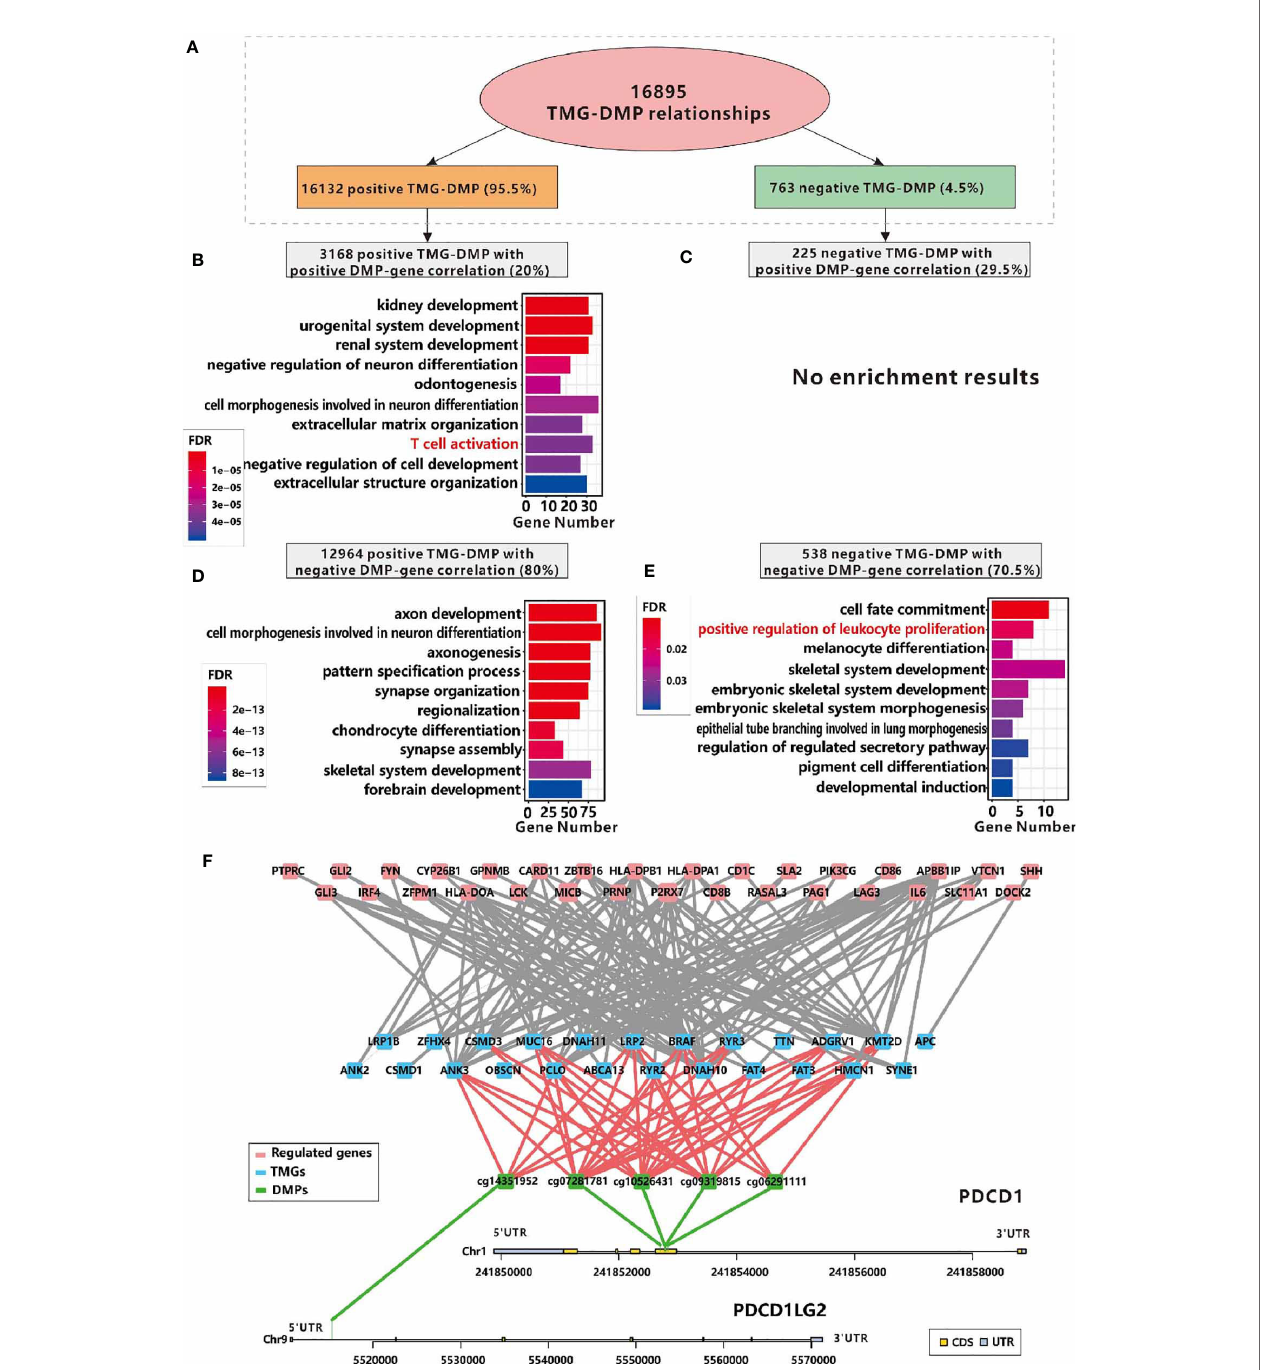
FIGURE 7 | Relationships between immune in fi ltration and DMPs regulated by TMGs in RCC. (A) The number and the proportions of positive and negative TMG- DMP relationships. (B) The GO functional enrichment analysis of the genes which are positively correlated with the DNA methylation level of TMG-upregulating DMPs. (C) No signi fi cant result was found in the genes which are positively correlated with the DNA methylation level of TMG-downregulating DMPs. (D) The GO functional enrichment analysis of the genes which are negatively correlated with the DNA methylation level of TMG-upregulating DMPs. (E) The GO functional enrichment analysis of the genes which are negatively correlated with the DNA methylation level of TMG-downregulating DMPs. (F) The network among TMGs (blue), DNA methylation probes (green) and genes (red) whose functions are annotated with T cell activation, of these, DNA methylation probes are derived from PDCD1 and PDCD1LG2